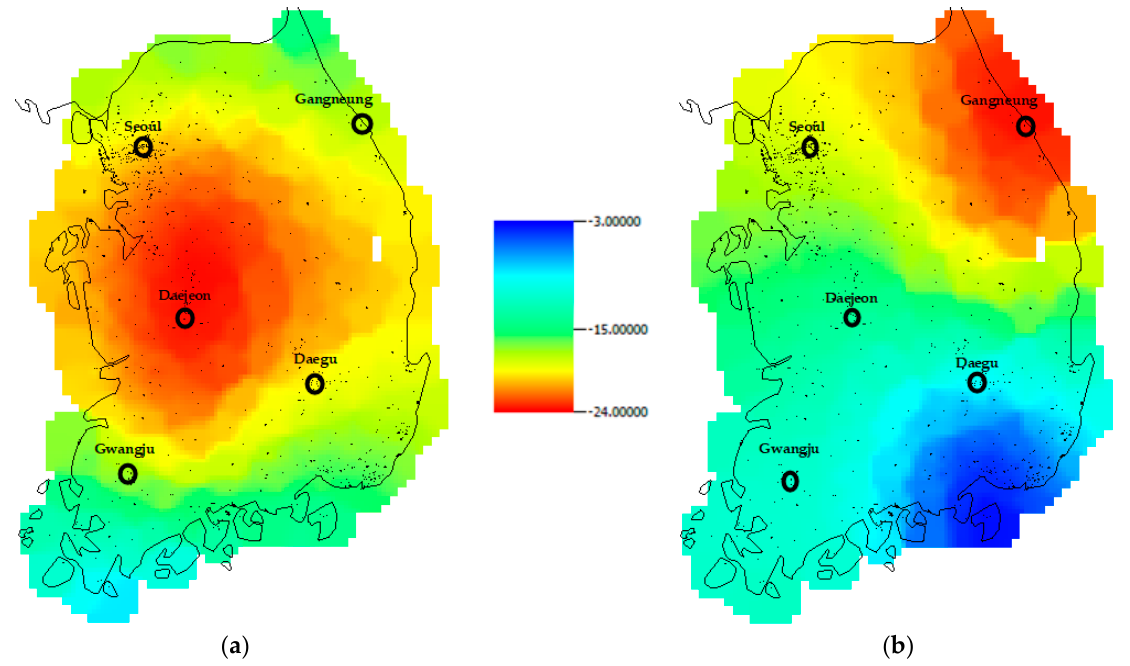
Figure 7. Geoelectric field magnitude over Korean electric power systems at the target locations at 60 s after an E3 HEMP detonation: ( a ) Daejeon; ( b ) Gangneung.